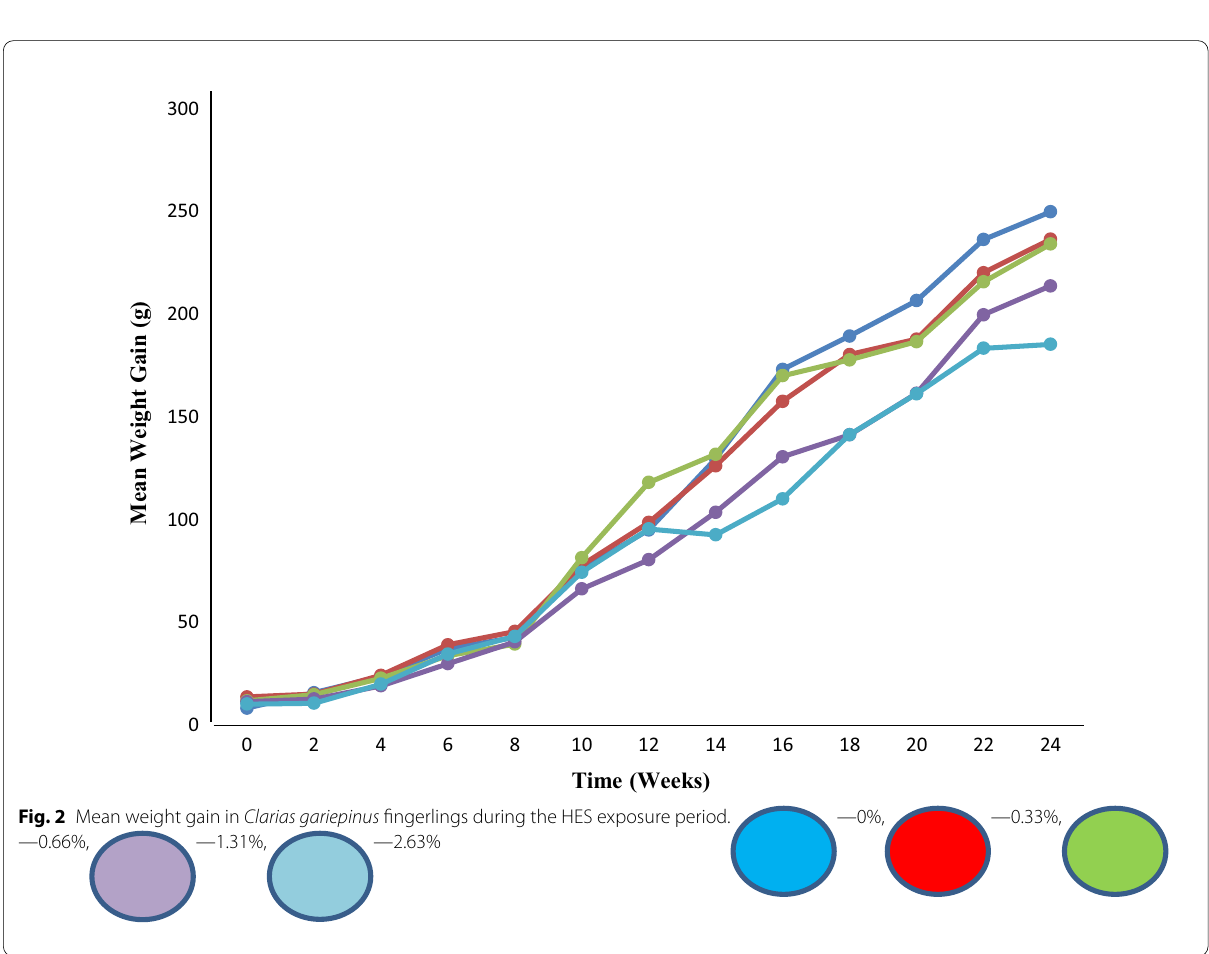
*Column mean values for each parameter with different superscripts are significantly different at p < 0.05 The * is a note to the usable of the superscript